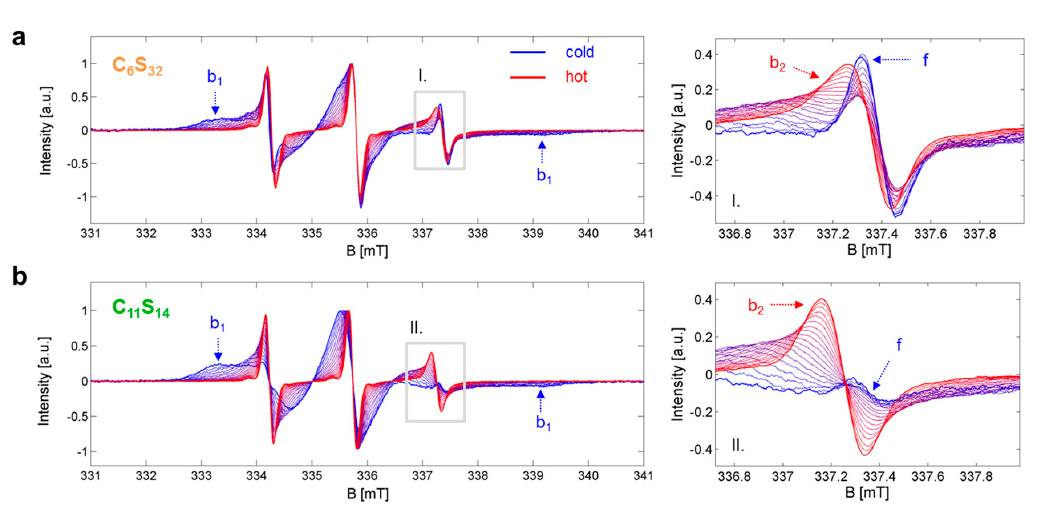
Figure 2. Temperature-dependent EPR spectroscopic datasets S j,k ( B ). ( a ) Core-shell polymer C 6 S 32 and ( b ) Core-shell polymer C 11 S 14 with the most prominent spectral features highlighted from dynamic fractions f , b 1 and b 2 . The gray insets (I. in ( a ) and II. in ( b )) on the left hand side are magnified on the right. EPR spectra were recorded [23] in the temperature range of 5 to 95 °C in steps of 5 K and the lowest (dark blue) and highest (dark red) temperature curve is depicted bold to create an envelope effect.